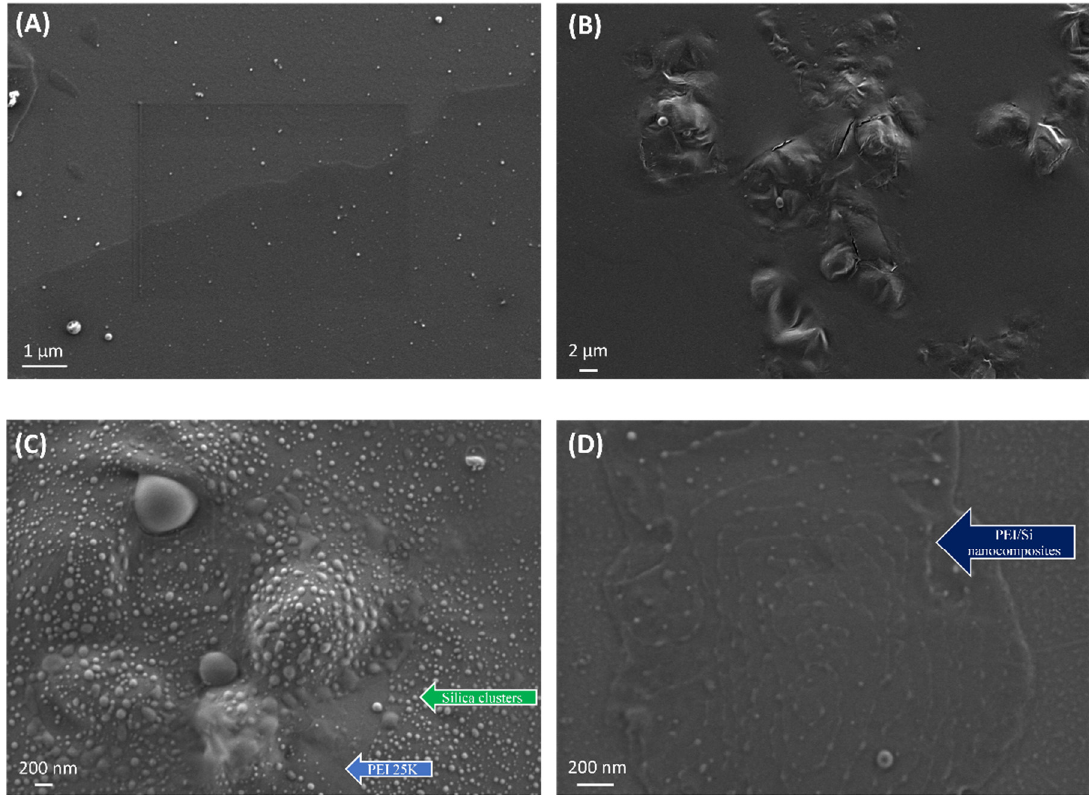
Figure 10. HR-SEM pictures of neat ( A ) silica nanoparticles and ( B ) PEI 25K, ( C ) a physical mixture of silica and PEI 25K and ( D ) PEI25/3/0.5 before extraction.